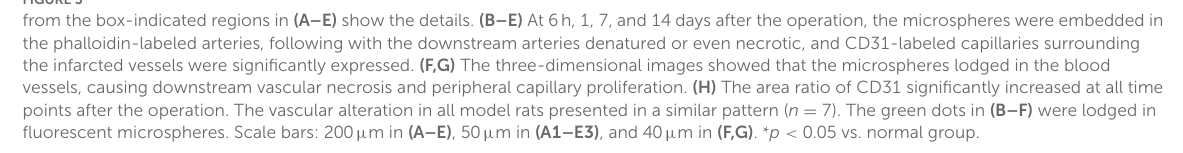
Photoshop CS5 (Adobe Systems, San Jose, CA, USA) and